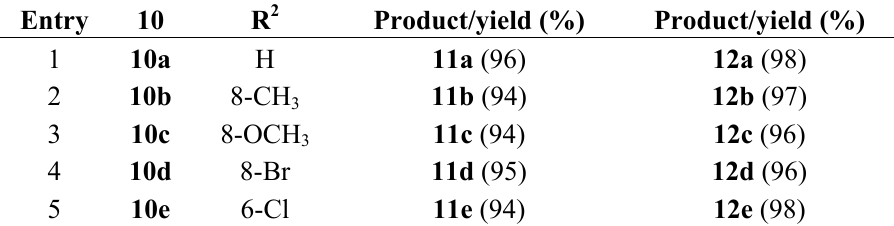
Table 3. Synthesis of 11a–e and 12a–e